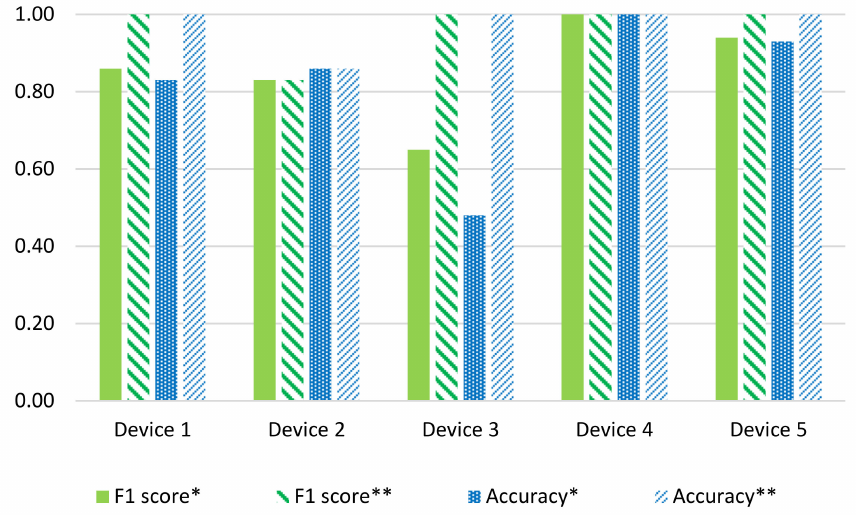
Figure 9. Performance (F1 score and accuracy) comparison of * SC-M and ** SC-EV for ideal data. The F1 score of both techniques is shown in green, while the accuracies of both techniques are in blue shades. Ideal data exhibits better performance than REFIT data because of low randomness and